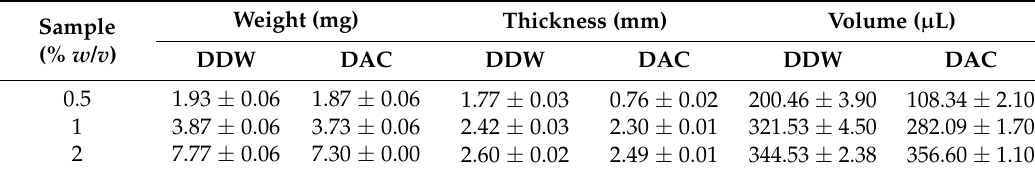
Table 4. Weight, thickness and volume of porous